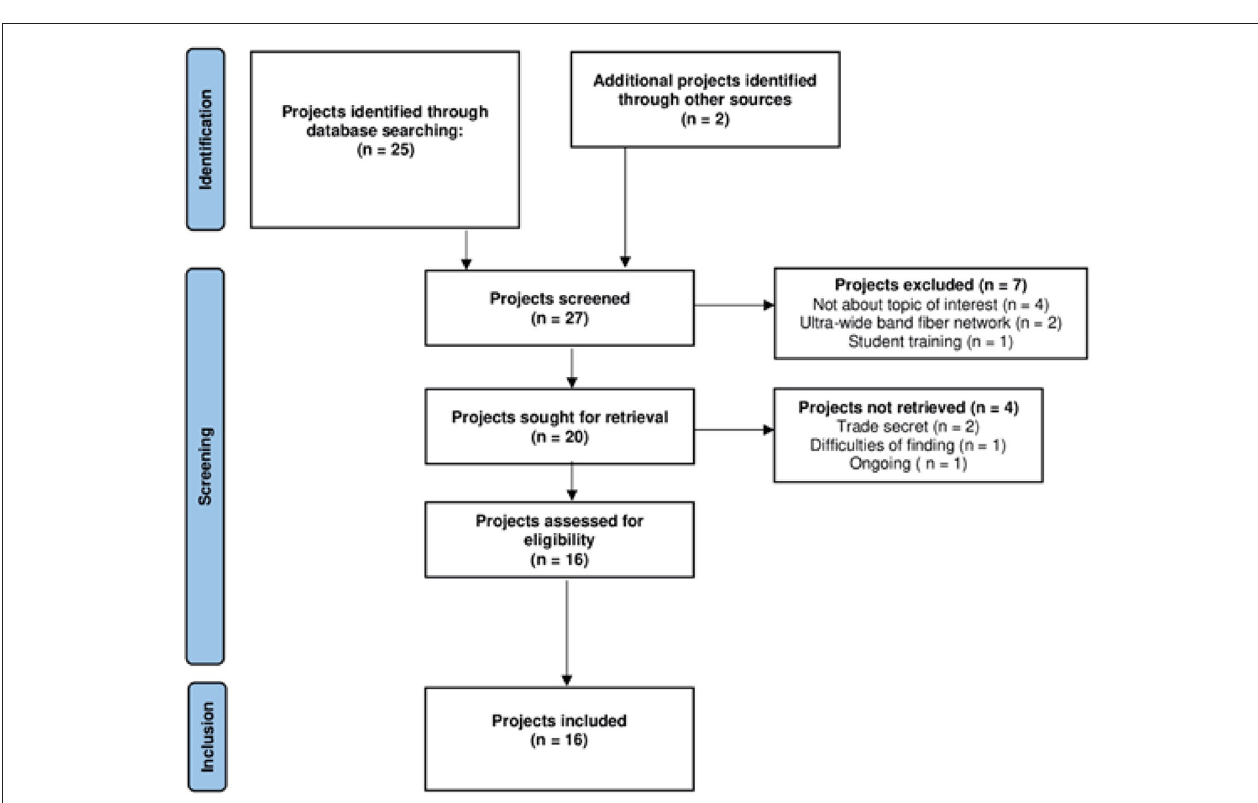
FIGURE 2 | Flow diagram of project search and